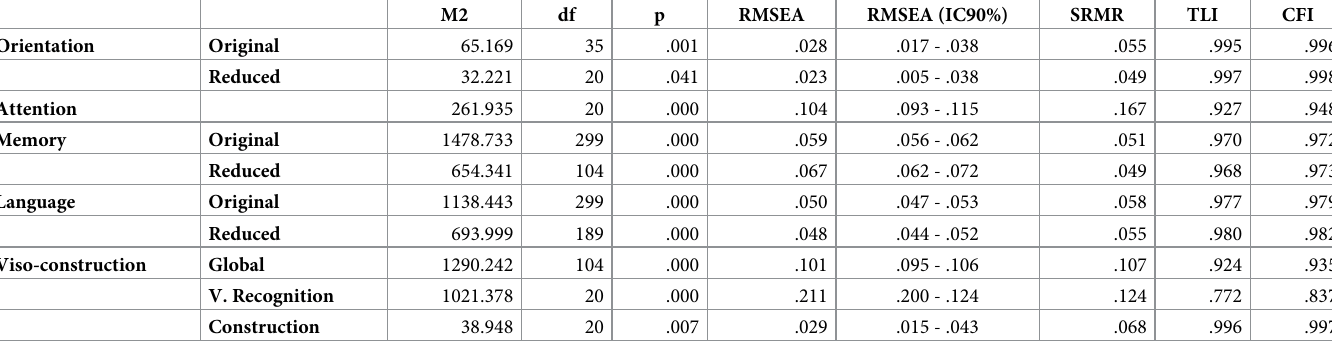
Table 3. Goodness of fit indices of the 2 parameter IRT model of each original subscale and reduced proposed version.